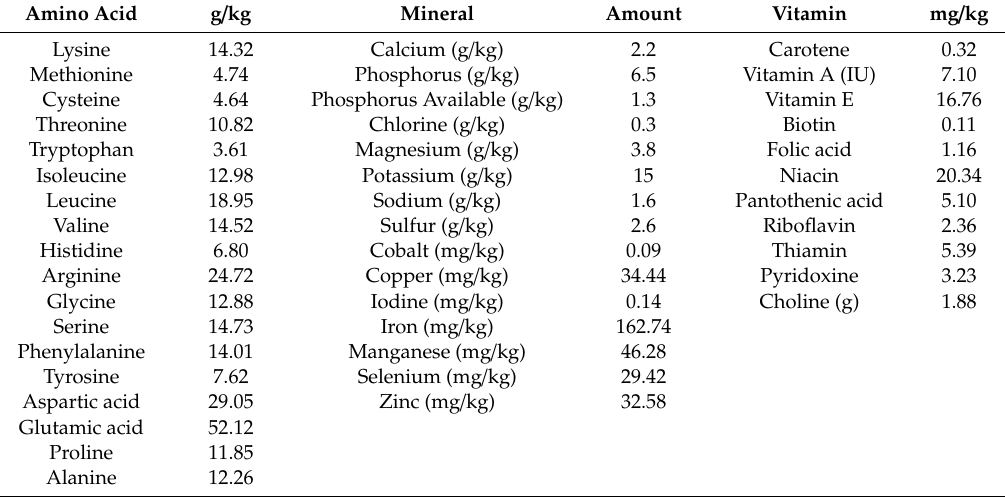
Amino acid, mineral, and vitamin concentrations in the extruded linseed and soybean supplement.